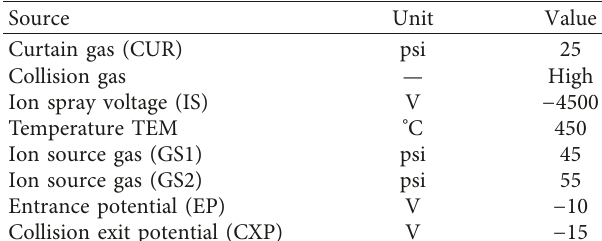
Table 3: Parameter used in